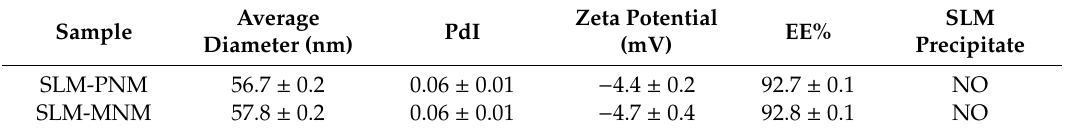
Table 4. Storage stability test of SLM-PNM and SLM-MNM at room temperature (Mean ± SD, n = 3).